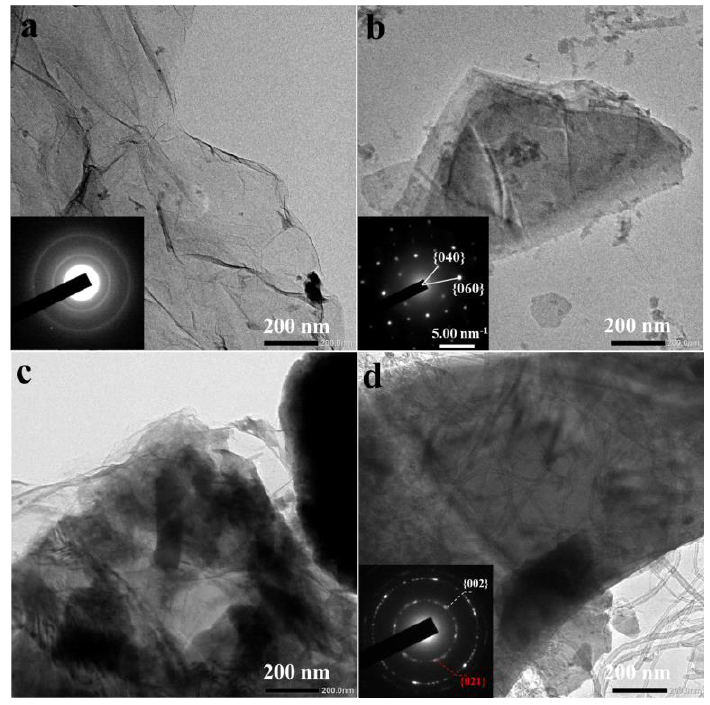
Figure 5. TEM of ( a ) GO, ( b ) B-AsP, ( c ) GO/B-AsP, and ( d ) GO/B-AsP/CNTs (inset: SAED pattern).